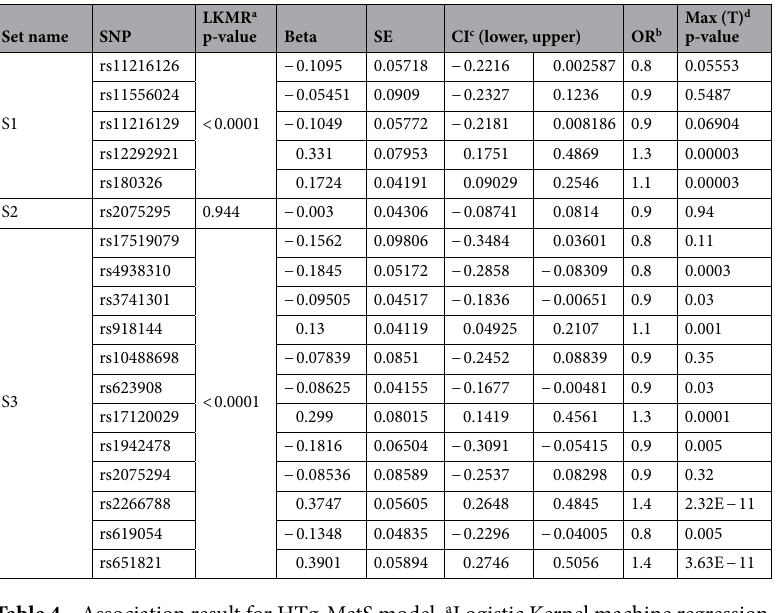
Table 4. Association result for HTg-MetS model. a Logistic Kernel machine regression. b Odd ratio for minor allele. c 95% confidence interval for BETA. d MAX(T) p-value with 1,000,000 replications.